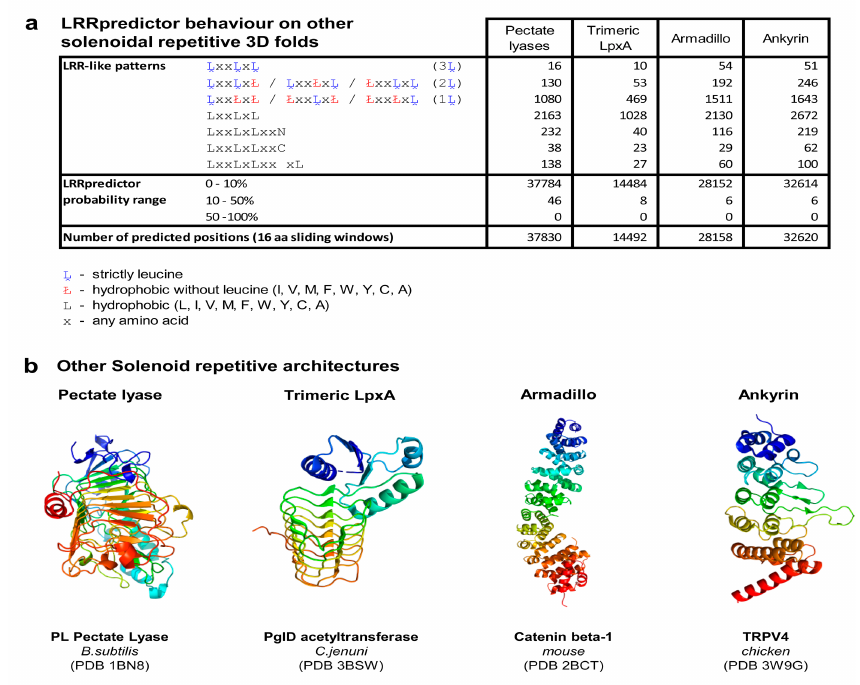
Figure A2. ( a ) LRRpredictor behavior on other solenoidal architectures. Shown are occurrence counts of LRR-like patterns versus LRRpredictor probabilities counts histogram. ( b ) Overall 3D structure of the four examined classes of solenoidal proteins [80–83].